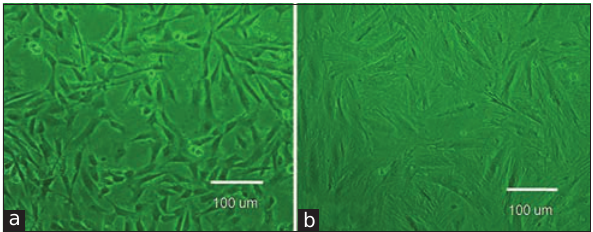
Figure-4: (a) Spindle-shaped fibroblastoid cells started to attach on day 4, (b) goat bone marrow-derived cells showing 80-90% confluence by day 16.